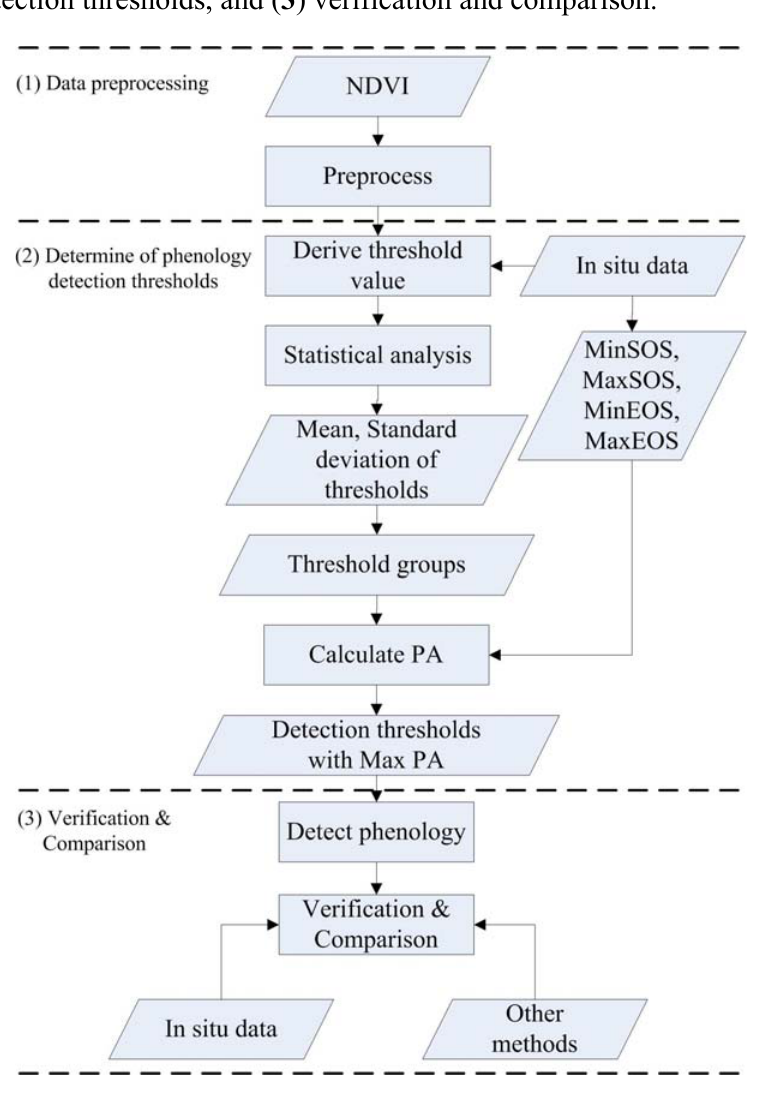
Figure 3. Study methodology consisting of ( 1 ) data preprocessing, ( 2 ) determination of phenology detection thresholds, and ( 3 ) verification and